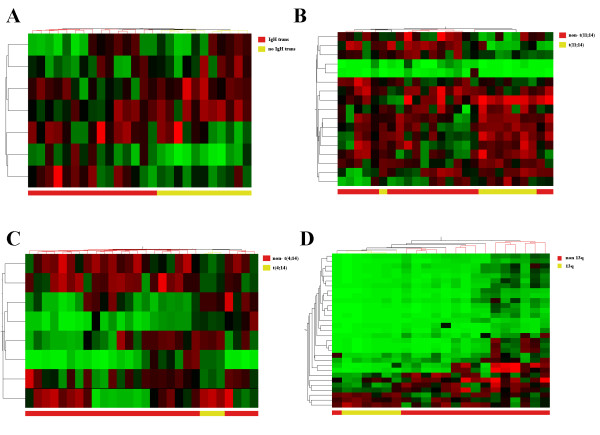
MicroRNA expression can distinguish between different genetic subtypes of MM. Cluster analysis heat maps depicting expression levels of microRNAs associated with (A) IgH translocation, (B) t(11;14), (C) t(4;14) and (D) del(13q).